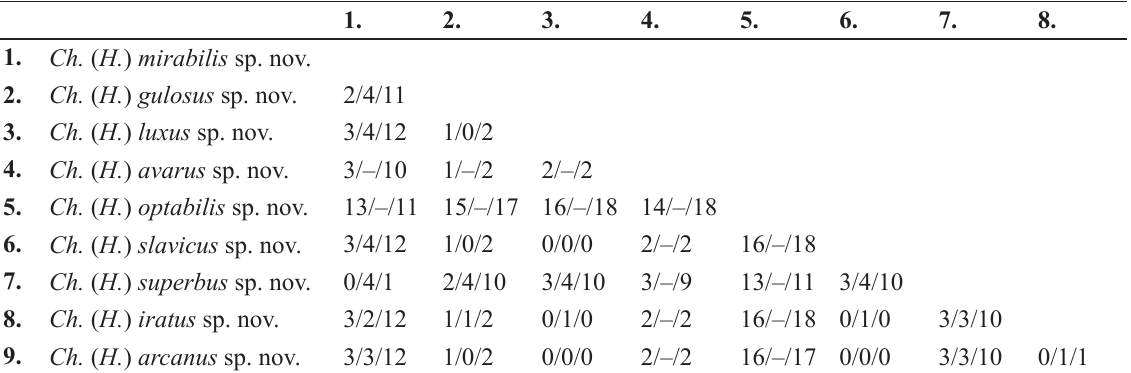
Table 3. Numbers of CBCs in the 18S, ITS2, and 28S molecules of nine new species of the subgenus Hystricochaetonotus Schwank, 1990. A dash (‒) indicates missing ITS2 sequences from Ch. ( H. ) avarus sp. nov. and Ch. ( H. ) optabilis sp.